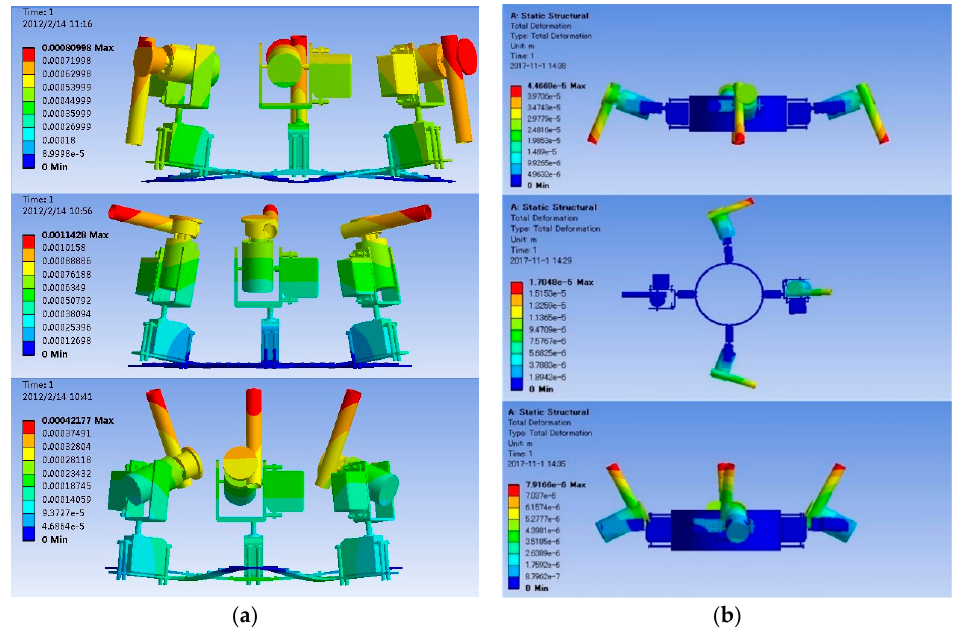
Figure 6. Deformation of the propulsion system. ( a ) Deformation of the propulsion system for SURII; ( b ) Deformation of the propulsion system for SURIII.